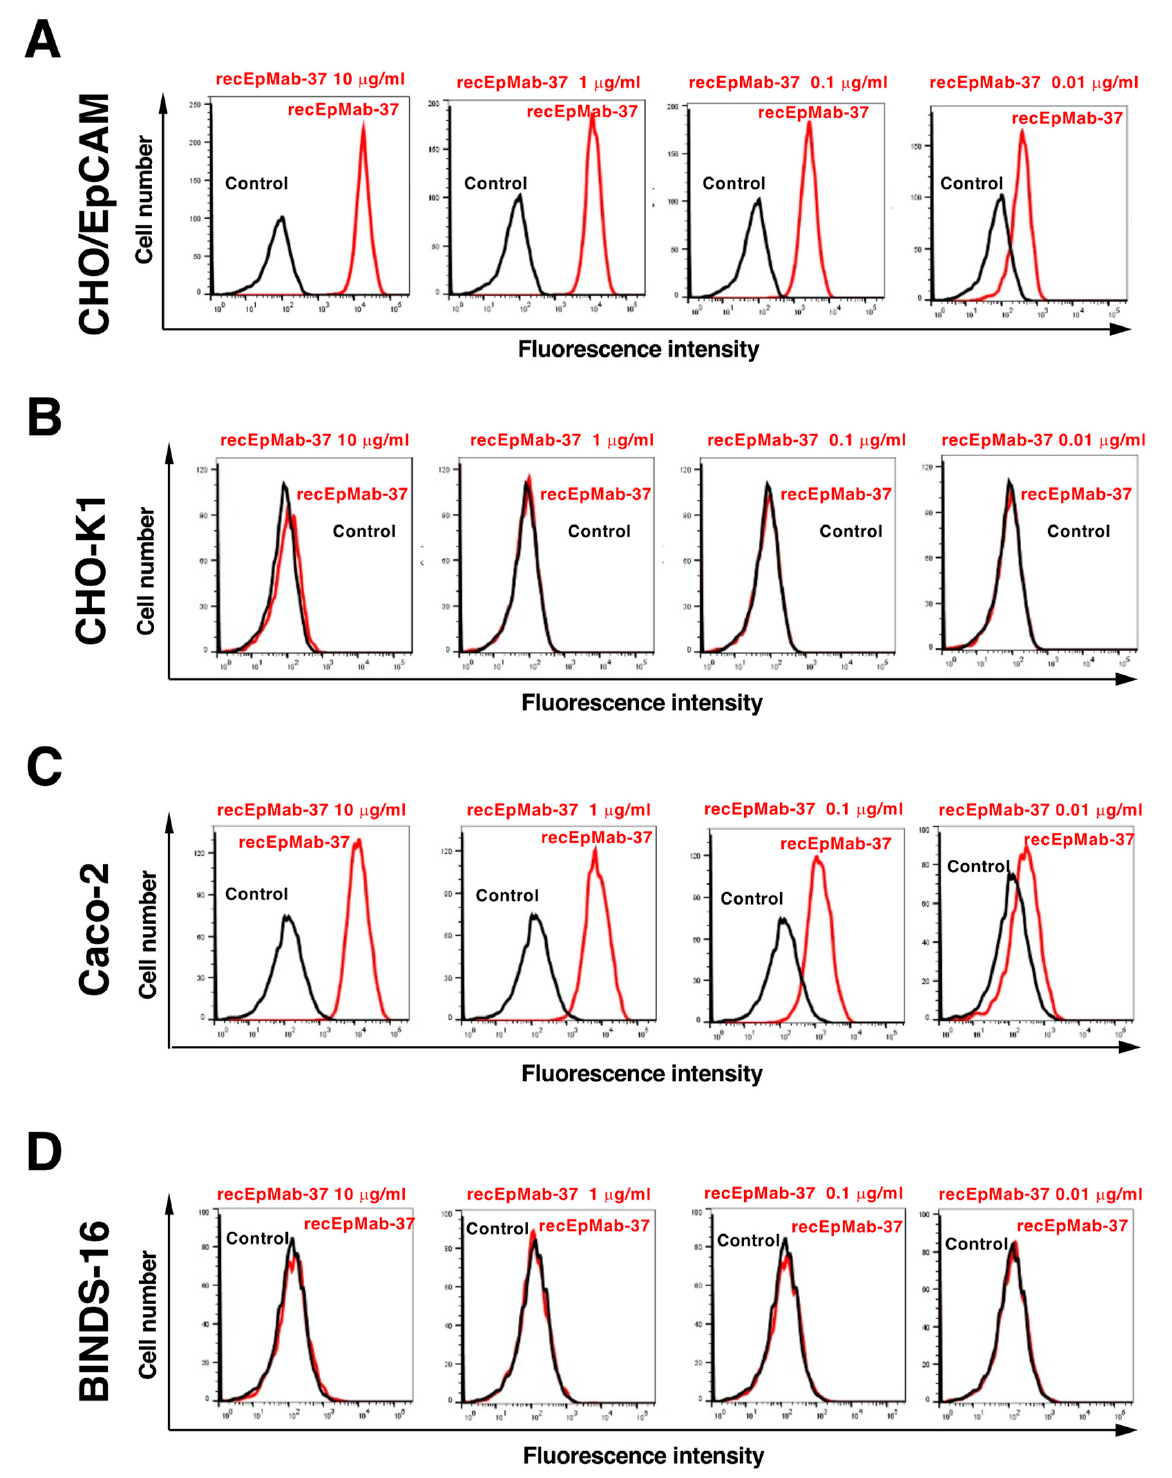
Figure 2. Flow cytometry of EpCAM expressing cells using recEpMab-37. CHO/EpCAM ( A ), CHO-K1 ( B ), Caco-2 ( C ), and BINDS-16 (EpCAM-knocked out Caco-2) ( D ) cells were treated with 0.01–10 µ g/mL of recEpMab-37, followed by treatment with Alexa Fluor 488-conjugated anti-mouse IgG. Black line represents the negative control.